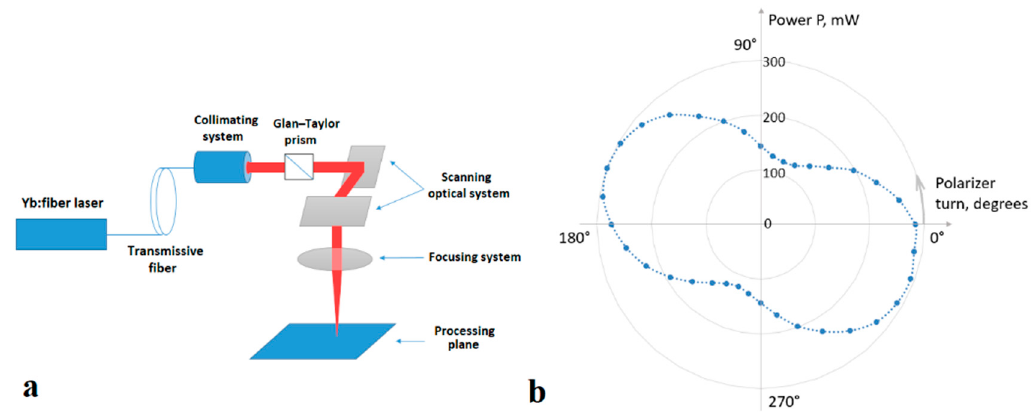
Figure 1. ( a ) E xperimental setup diagram; ( b ) results of measuring the power of laser radiation after the optical system depending on the rotation angle of the polarizer (Glan–Taylor